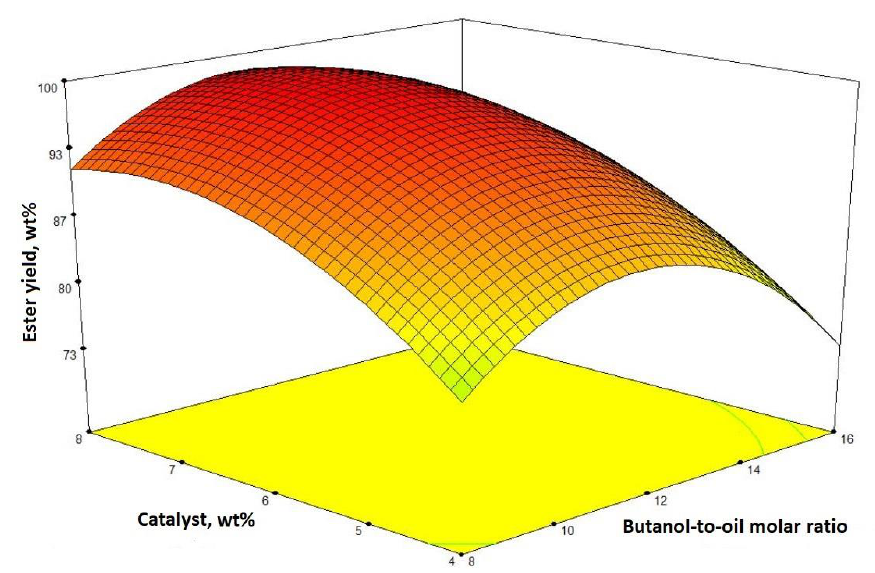
Figure 1. The interaction between the catalyst content and the 1-butanol-to-oil molar ratio for the ester yield (the process time is 12 h) presented by a response surface contour plot.